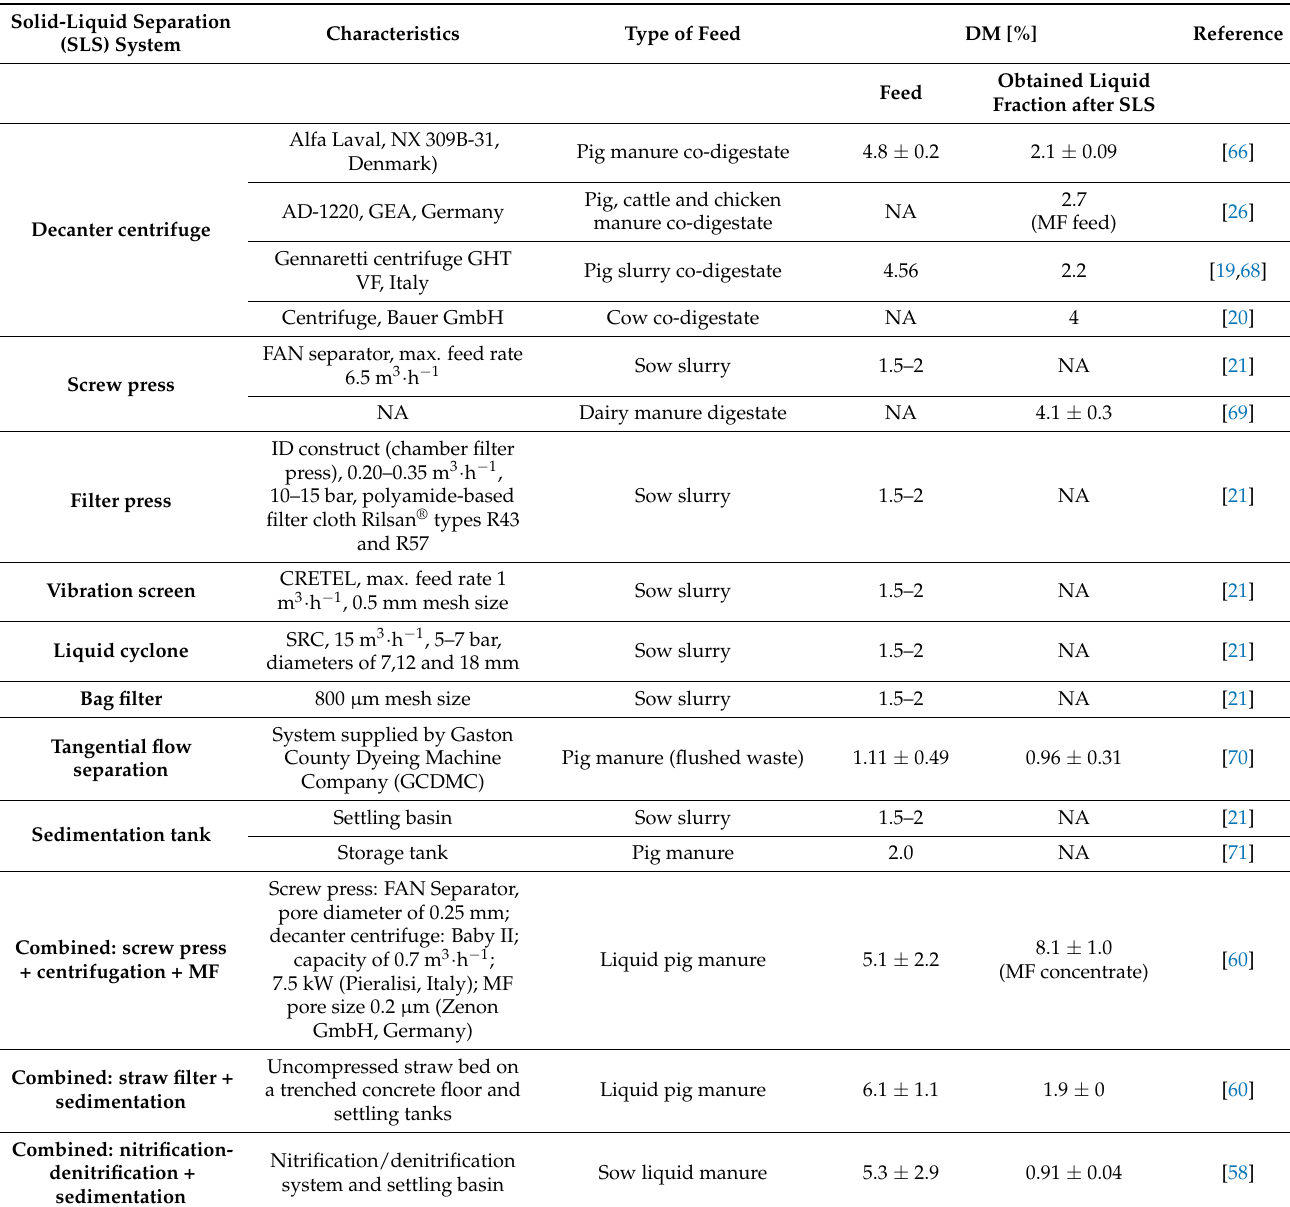
Table 1. Main manure SLS systems with characteristics of obtained liquid